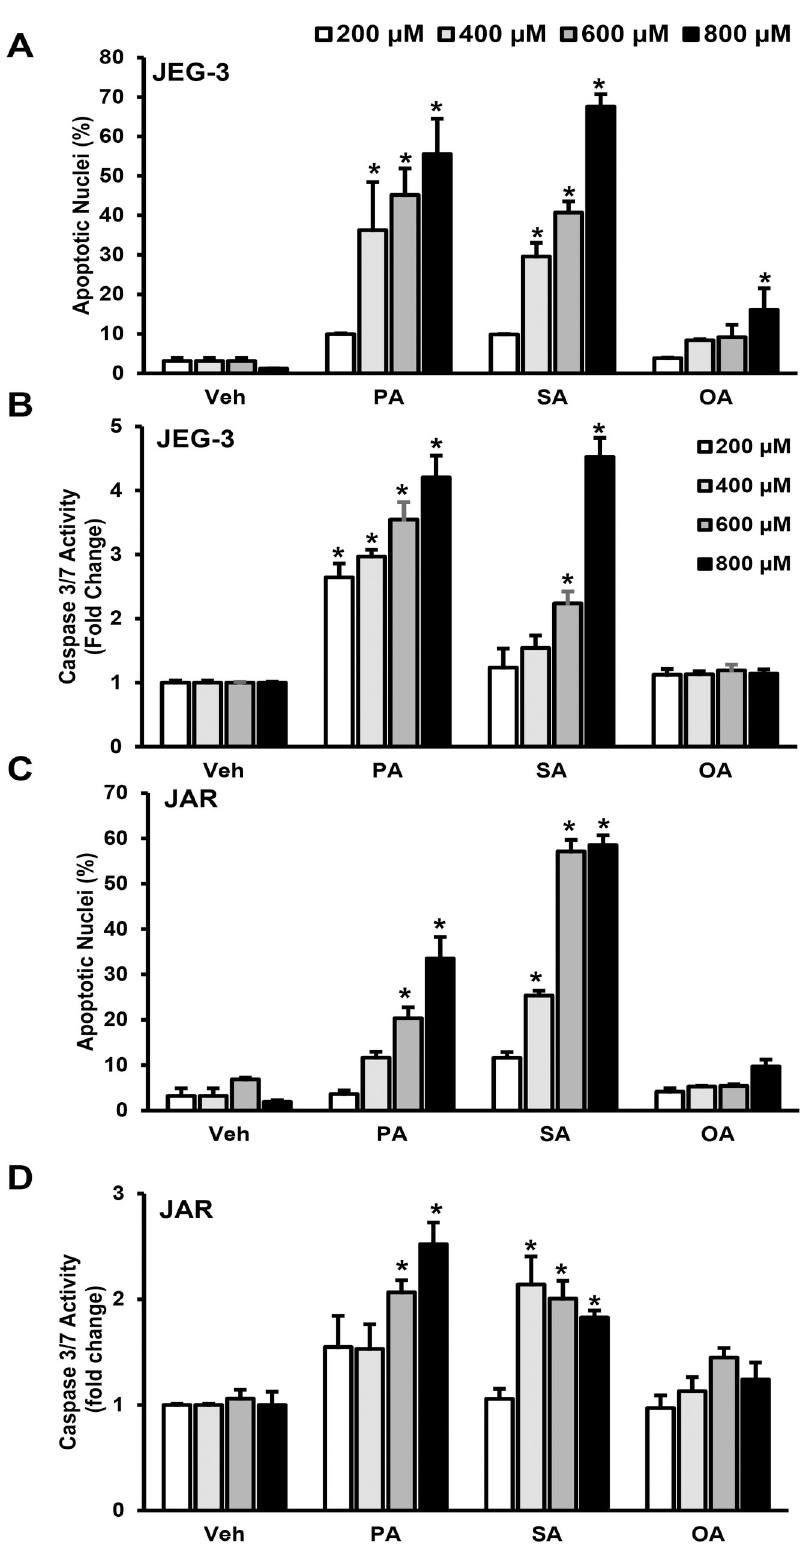
Fig 1. FFAs induce trophoblast lipoapoptosis. Cells were treated with palmitate (PA), stearate (SA), oleate (OA) or vehicle (Veh) for 24 h in JEG-3 (A, B) and JAR cells (C, D). Percent apoptotic nuclei (A and C) and caspase 3/7